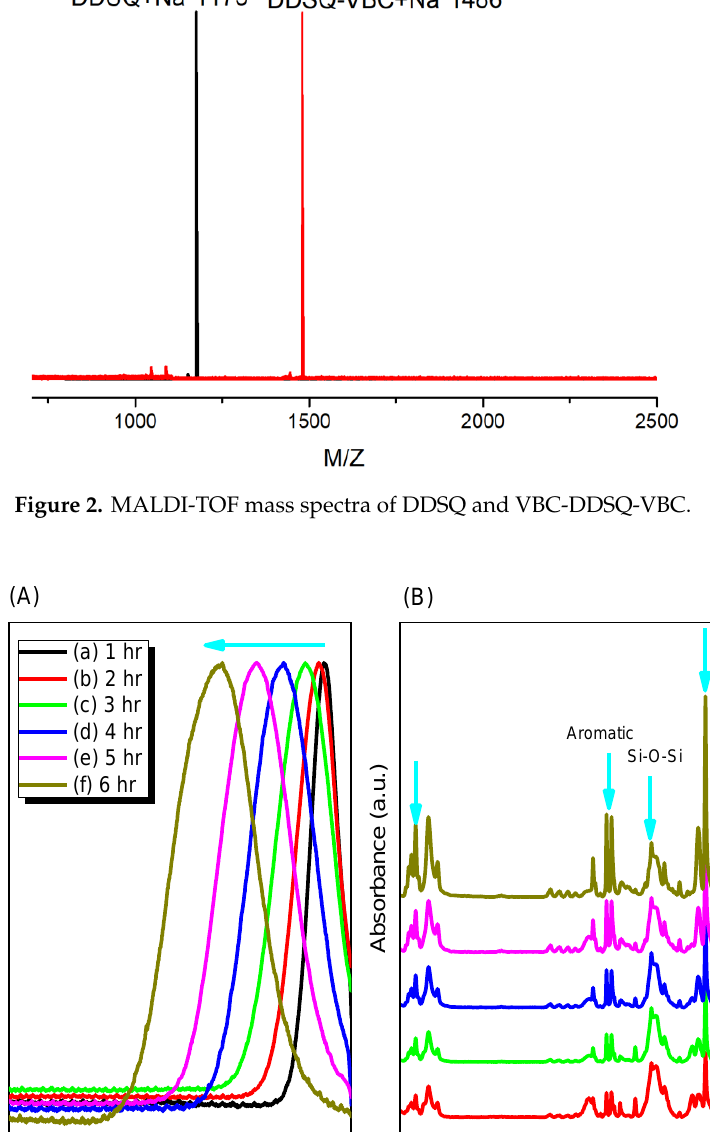
Table 1. Molecular weights of PS- b -DDSQ- b -PS polymers used in this study. Sample